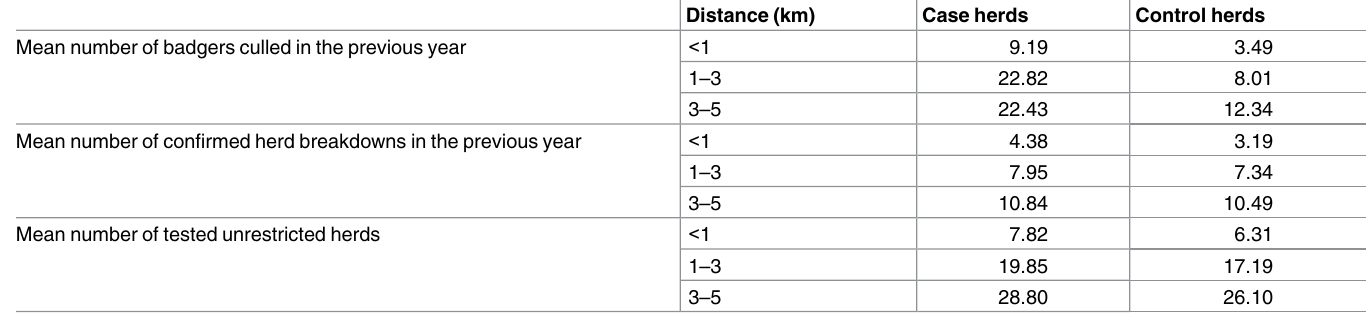
Table 1. Mean number of badger culled in the previous year, number of confirmed herd breakdowns in the previous year, and number of tested unrestricted herds in each circle or annulus for case and control herds.